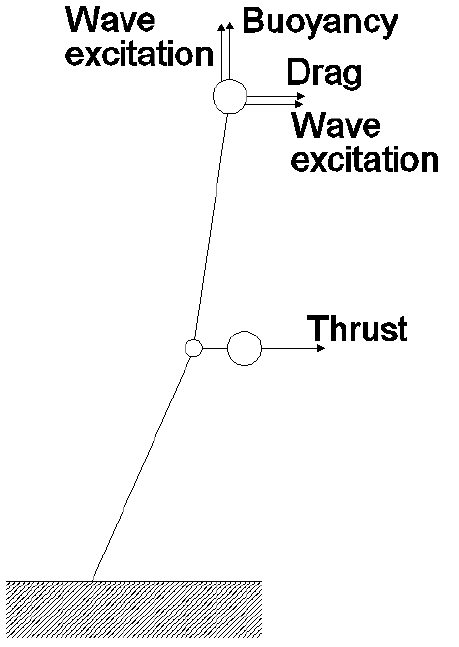
Figure 4. Forces on the